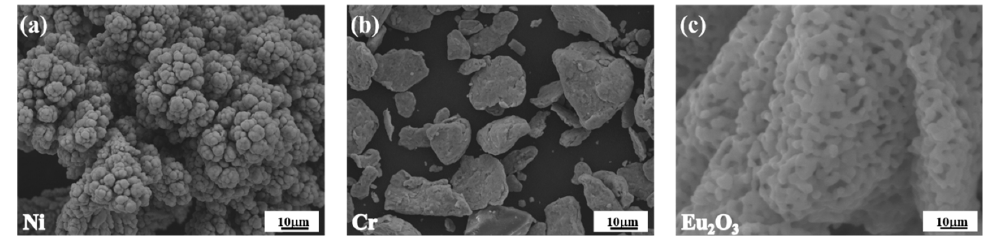
Figure 1. SEM images of raw materials:( a ) Ni; ( b ) Cr; ( c ) Eu 2 O 3 . Table 1. The composition (wt.%), experimental density, theoretical density, and relative density of specimens.